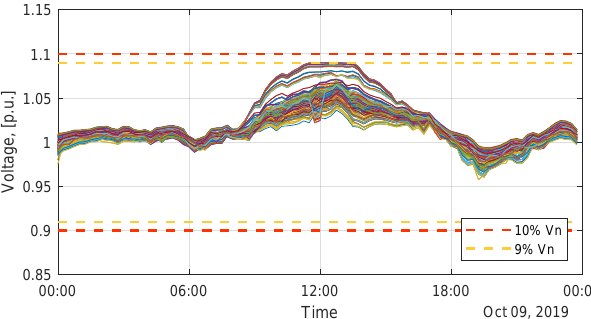
Figure 12. Simulation results. Forecasted voltage profiles, before the application of the LVC.